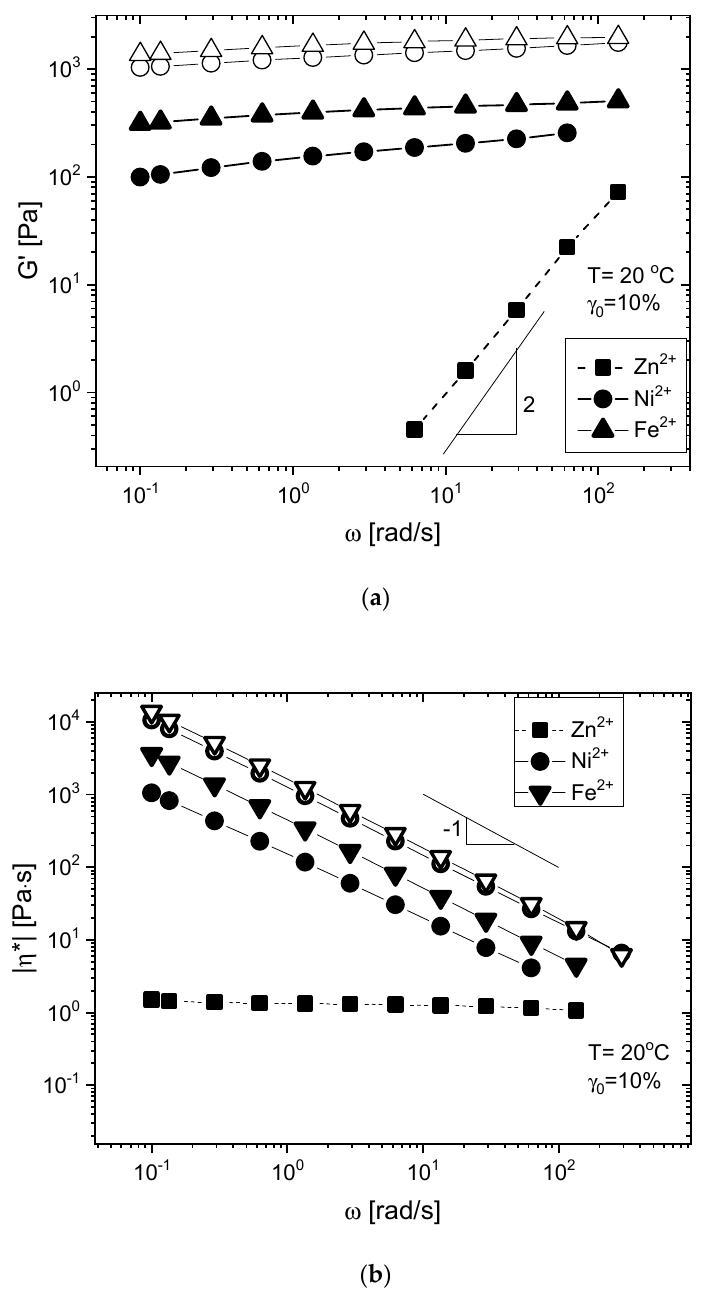
Figure 5. Frequency-dependent rheological data for ( a ) G’( ω ) and ( b ) | η *( ω )| at T = 20 °C. Filled symbols: 12 w/v% concentration, from ref [7]. Open symbols: 15 w/v% concentration.